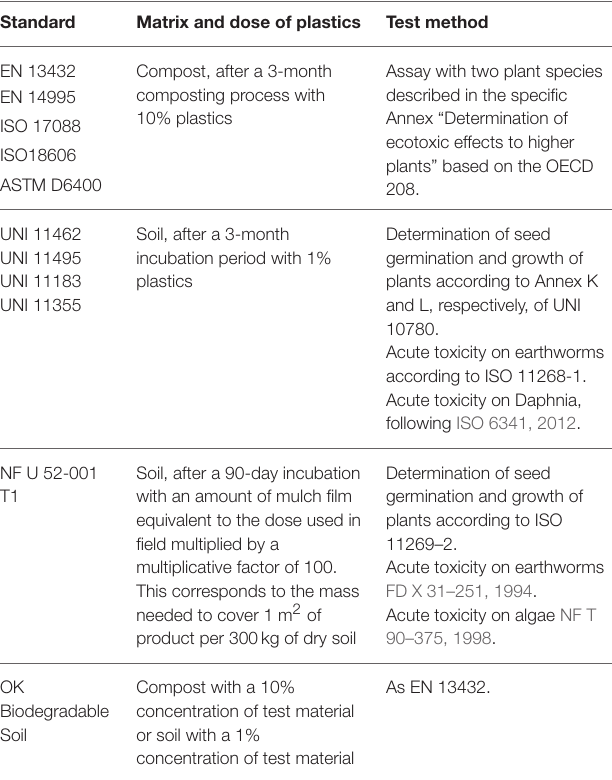
TABLE 2 | Bio-tests for ecotoxicity considered by the different standards on biodegradable plastics and packaging.